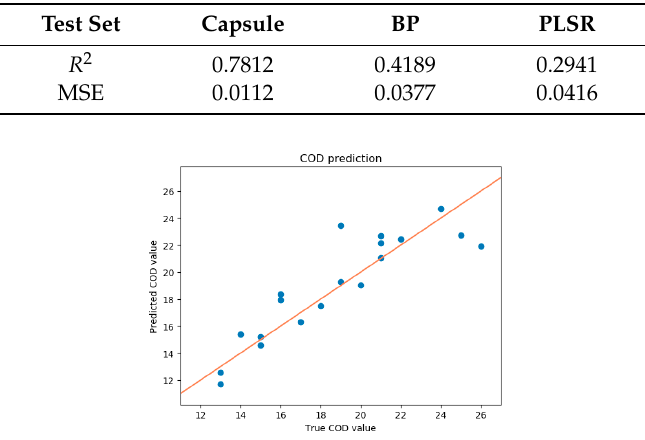
Figure 8. Chemical oxygen demand (COD) prediction by capsule model.